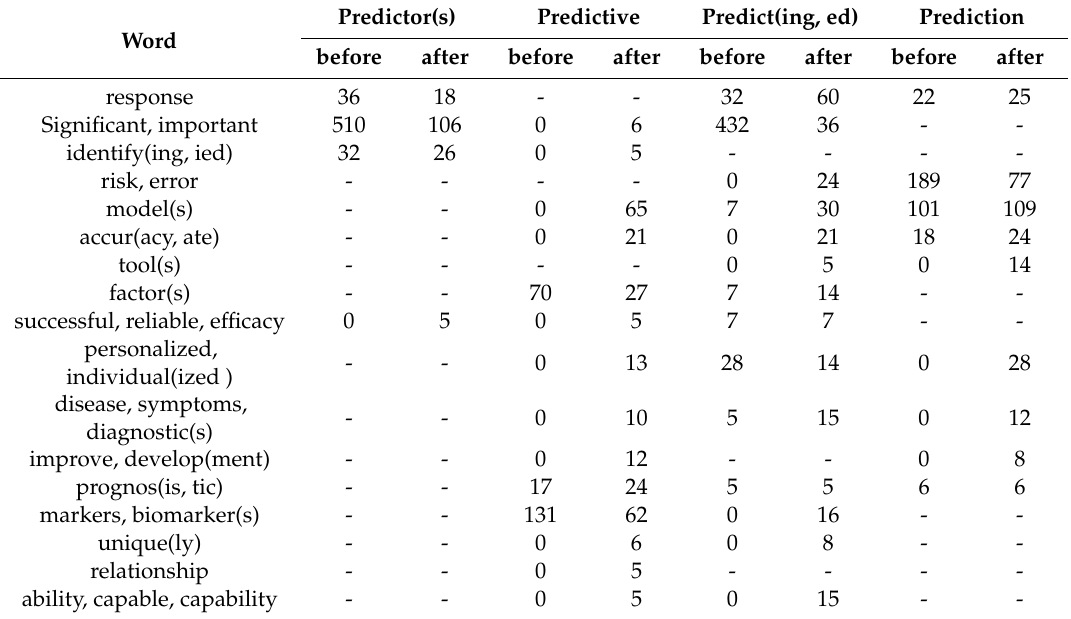
Table 7. Combined use of significant terms with derivatives (predictor(s), predictive, predict(ing, ed), prediction) before and after 2007.